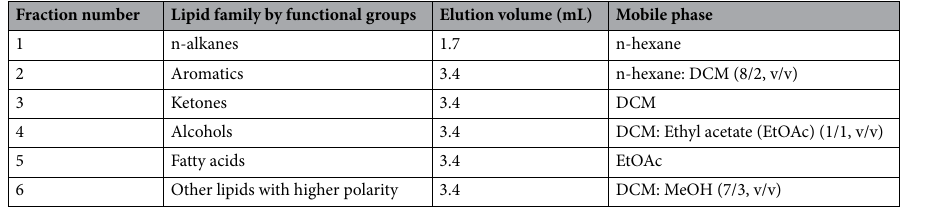
Table 4. Lipid fraction